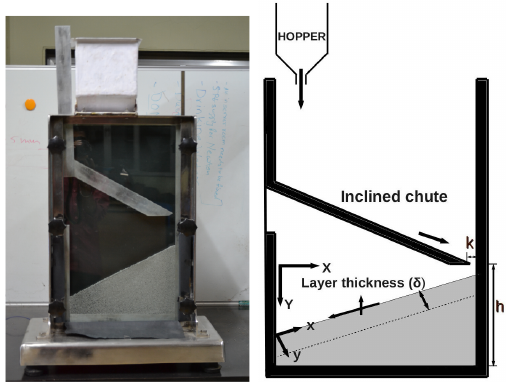
Figure 1. Experimental setup: quasi-2-dimensional rectangu- lar bin& Schematic view of heap formation,showing feeding ar-